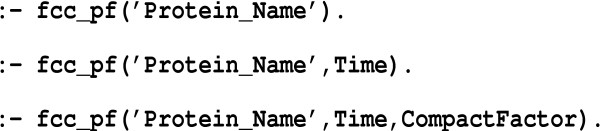
Program execution modes.